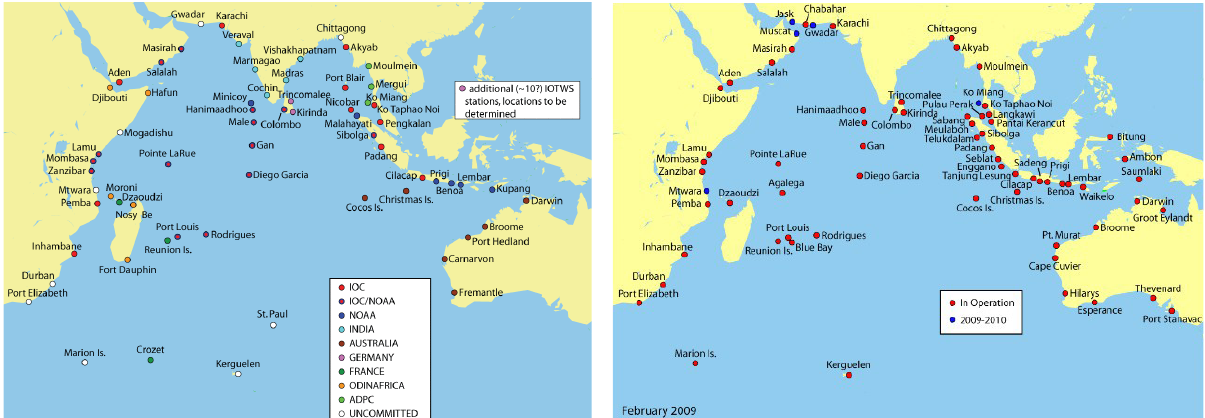
Fig. 2. Recommendation of Working Group 2 for the establishment of an Indian Ocean wide tide gauge network. Left: plan developed min 2005. Right: status of the network in 2009 (the blue marked tide gauges for 2009–2010 are in operation now).